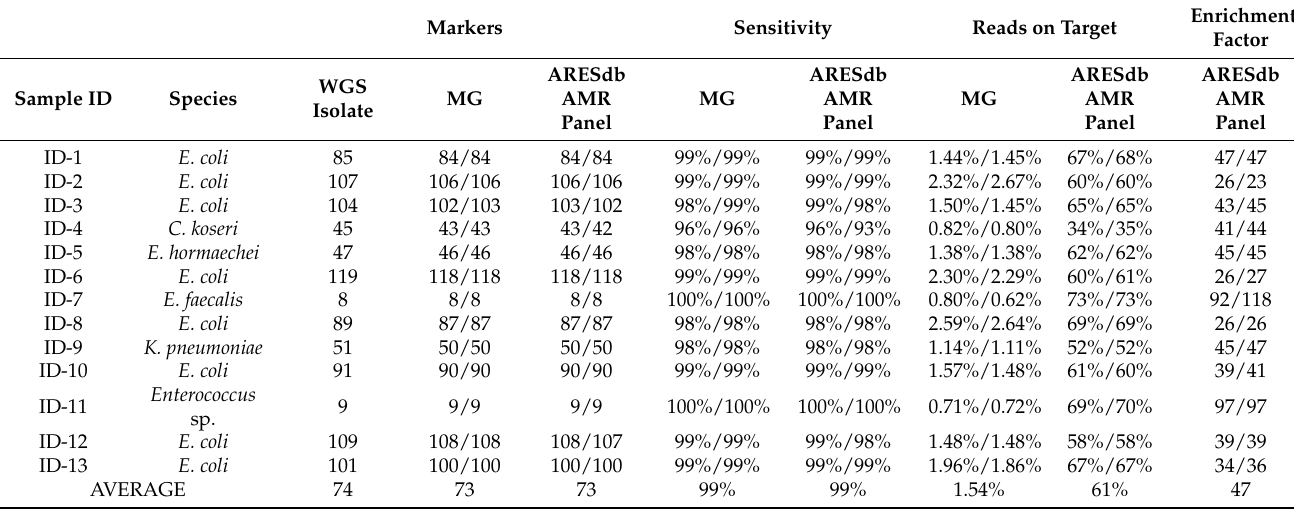
Comparison of performance parameters for metagenomics sequencing (MG) and target-enriched sequencing (ARESdb AMR panel). The number of ground truth markers was defined based on the whole genome sequence of the bacterial isolate (WGS isolate). Samples were processed as duplicates and represented as (Duplicate 1/Duplicate